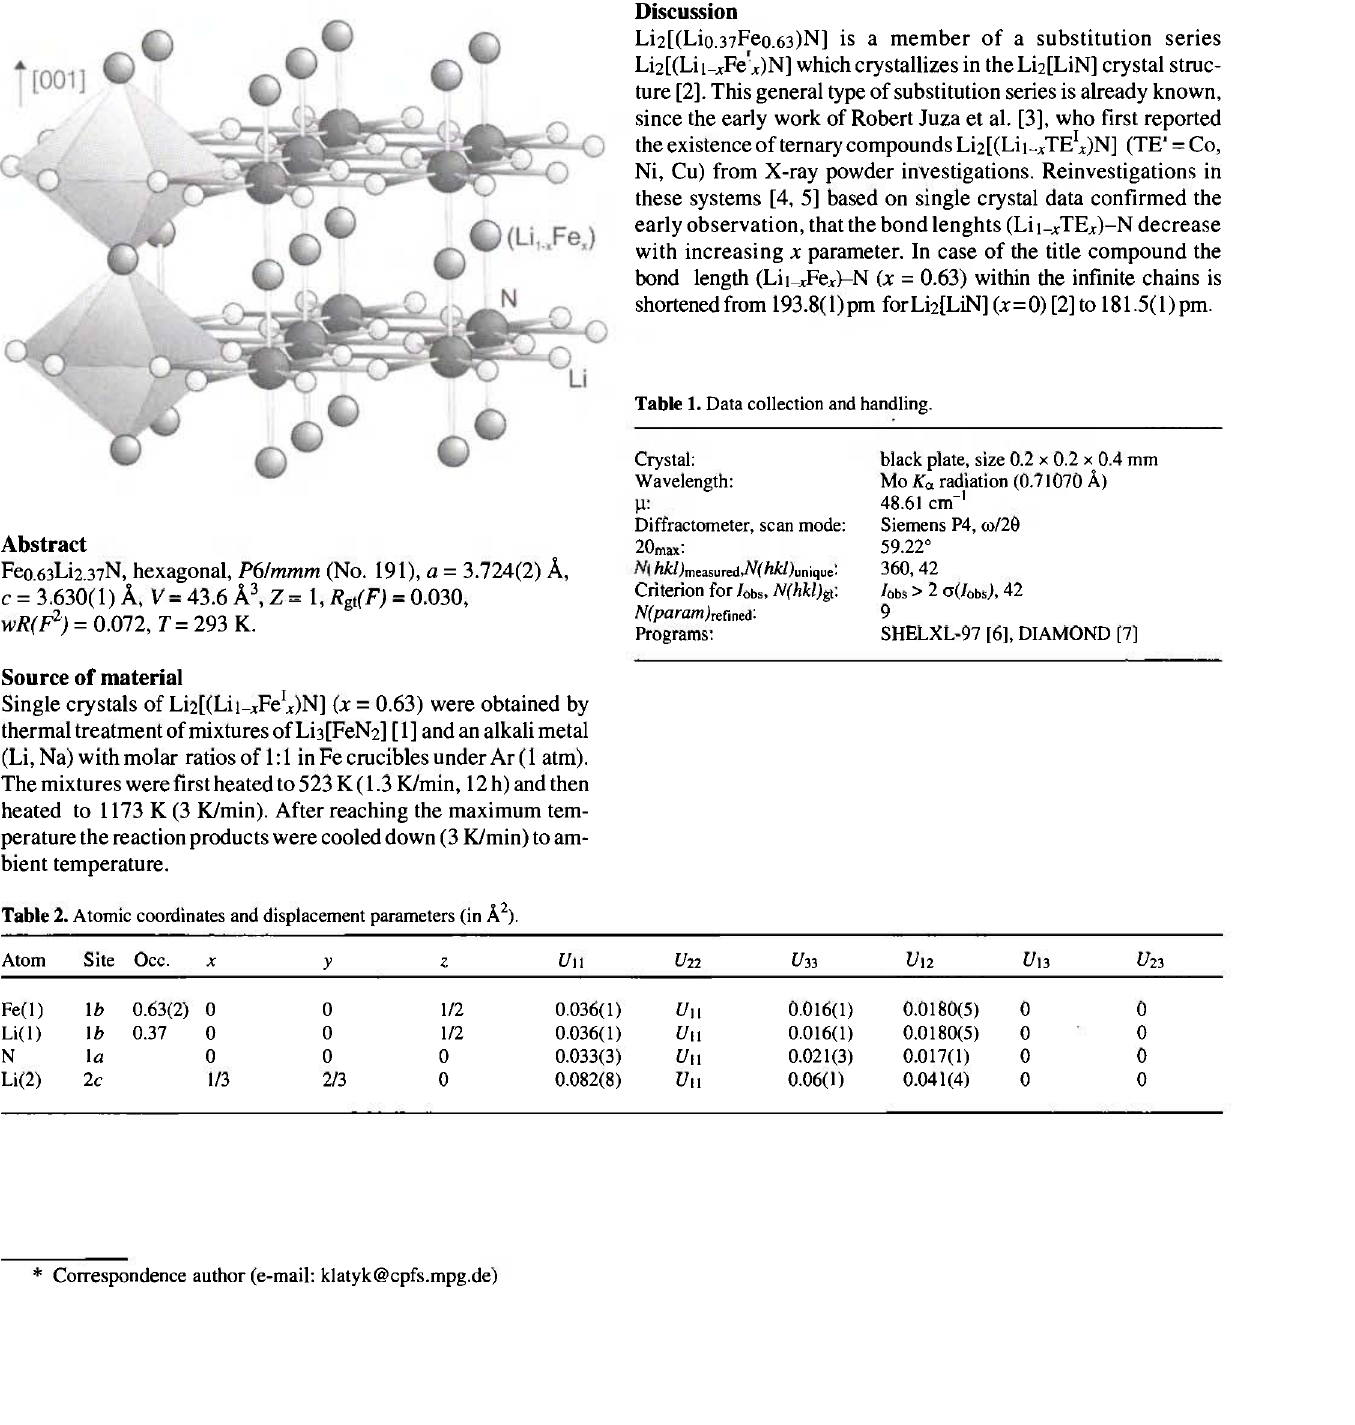
Table 1. Data collection and